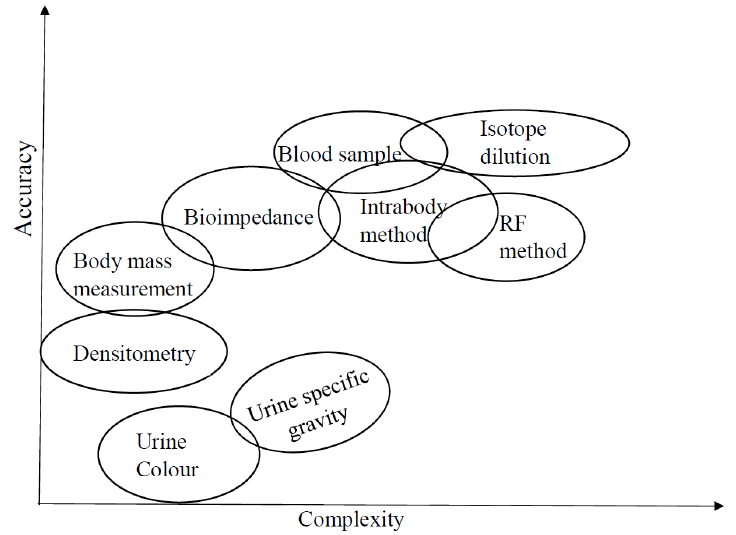
Figure 5. Comparison of body fluid assessment techniques by accuracy and